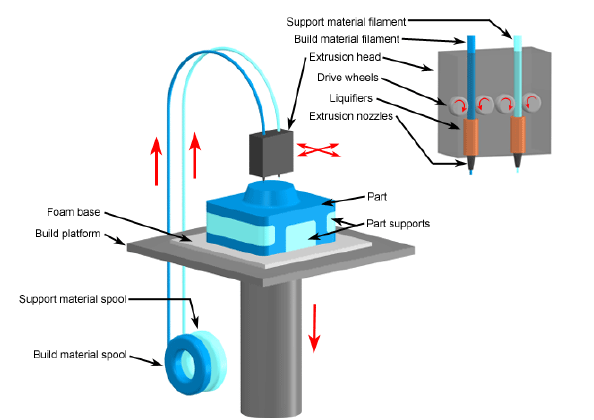
Fig. 4 The principle of FDM technology [10] As we can see in Table 1, dimensions of printed wheels vary and differ from original plastic wheel. d 2 b differ 2